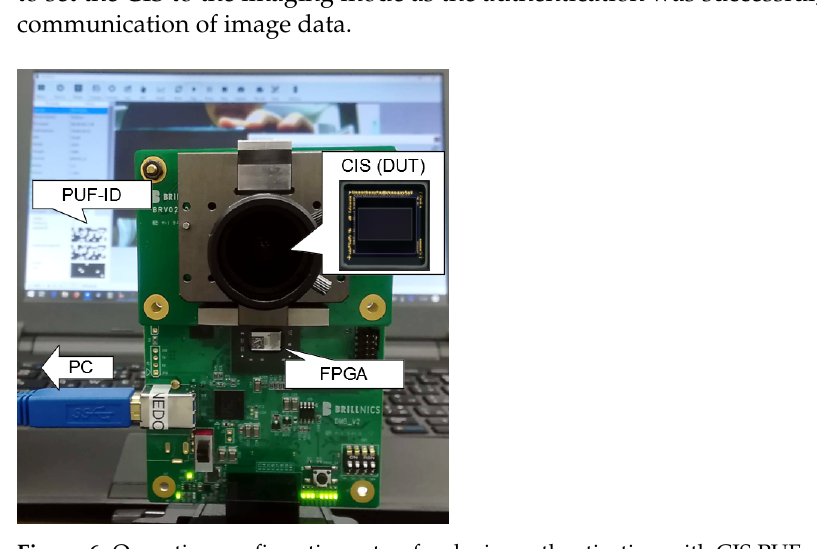
Figure 6. Operation confirmation setup for device authentication with CIS PUF.